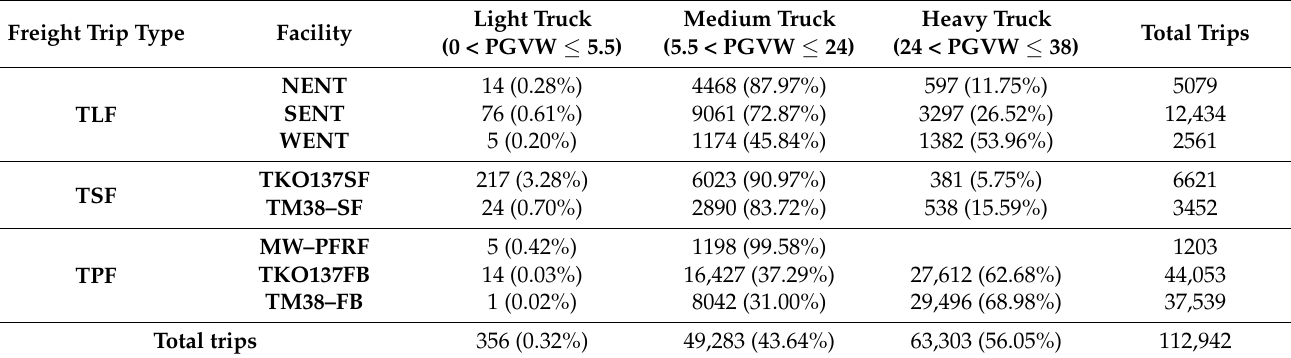
Table 6. Distribution of trips by vehicle types.